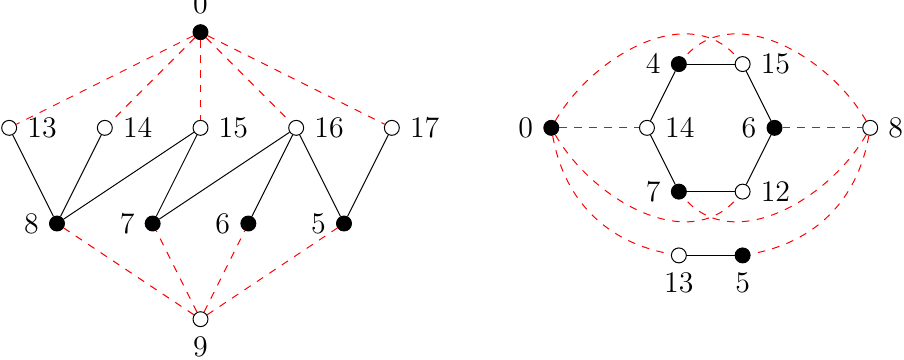
Figure 6: α -labelings of graphs containing smaller α -graphs